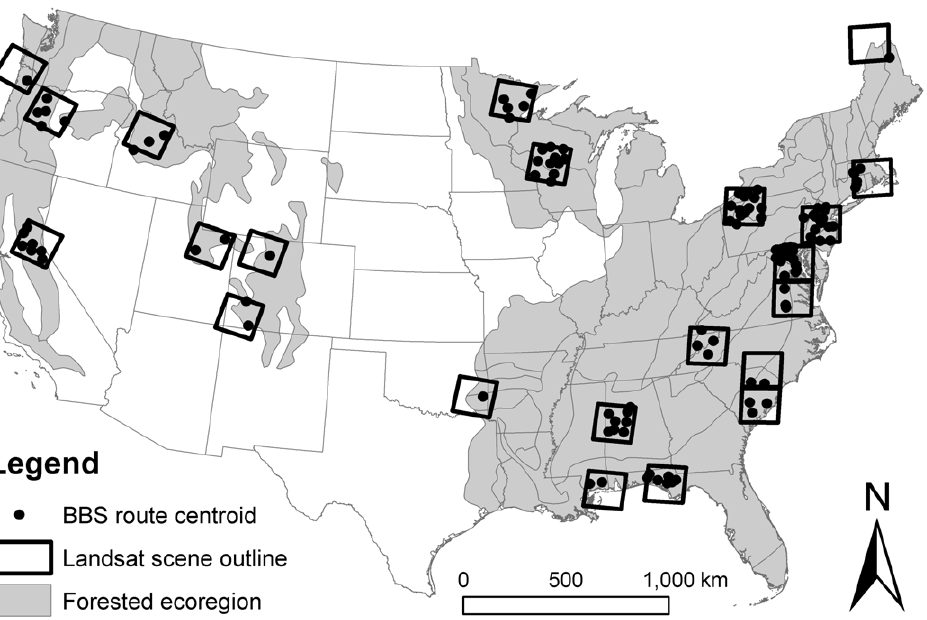
Figure 1. Location of the 122 Breeding Bird Survey (BBS) routes with sufficient data for analysis and corresponding Landsat scene outlines.